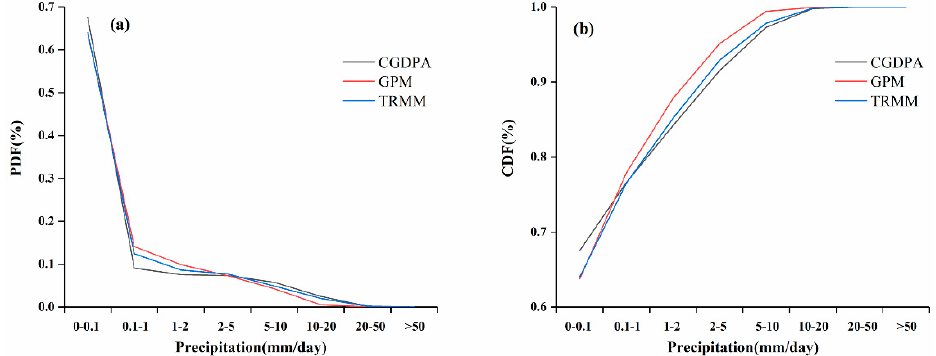
Figure 5. ( a ) The Probability Density Function(PDF) plot of the average daily precipitation in the HRB. ( b ) The Cumulative Distribution Function(CDF) plot of the average daily precipitation in the